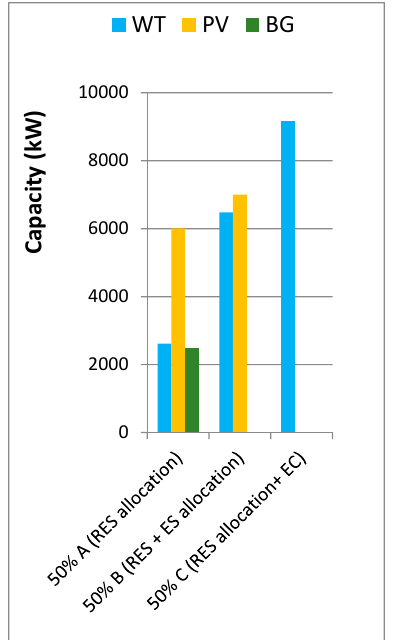
Figure 6. Structure of capacity for main scenarios—3.